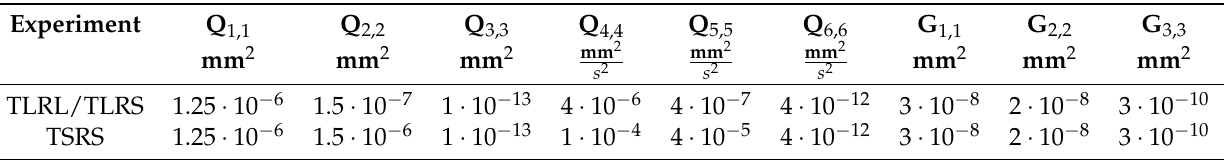
Table 4. Diagonal elements of process noise and measurement noise covariance matrices. The off-diagonal elements are assumed zero, thus making the assumption of uncorrelated noise